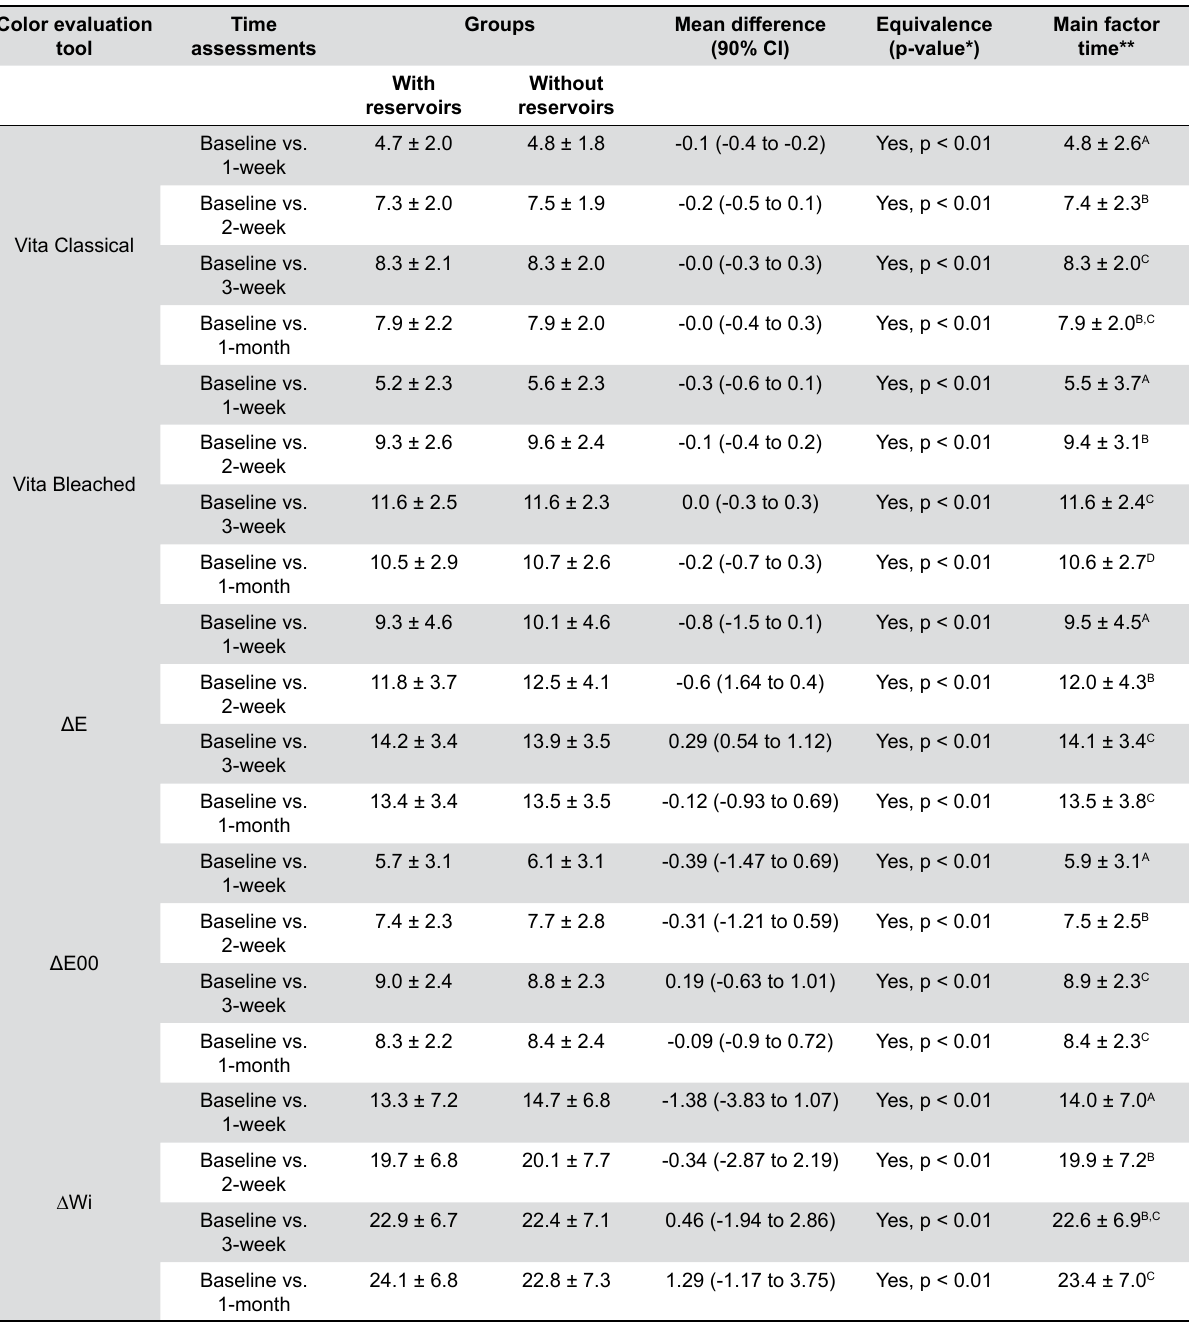
Table 1- Means ± standard deviations of ΔSGU, ΔE, ΔE00 and ∆Wi obtained by the color change instruments at different time assessments and the mean difference (90% confidence interval [CI]) for the pairwise